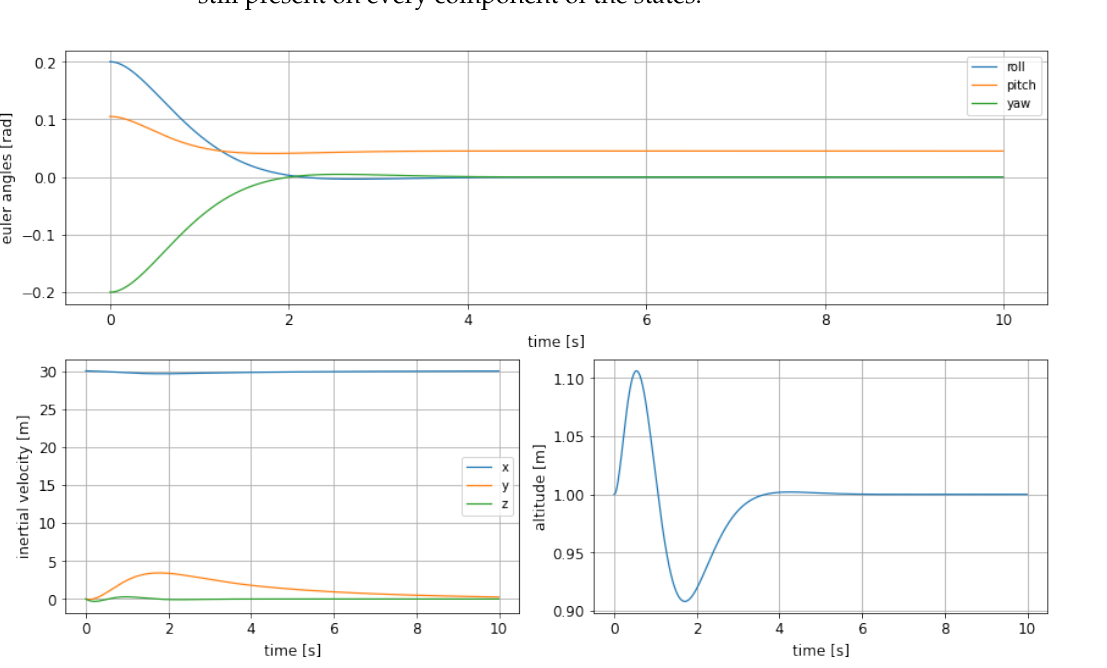
Figure 9. Euler angles ( top ), inertial velocities ( bottom left ) and altitude change ( bottom right ) using LQR control on linearized system, starting from disturbed